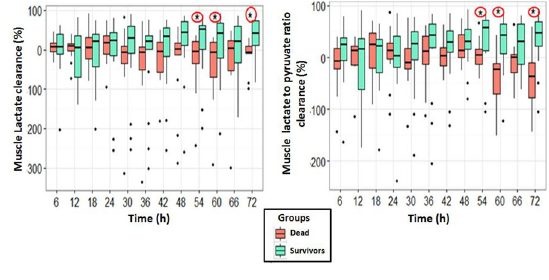
with decreased mortality